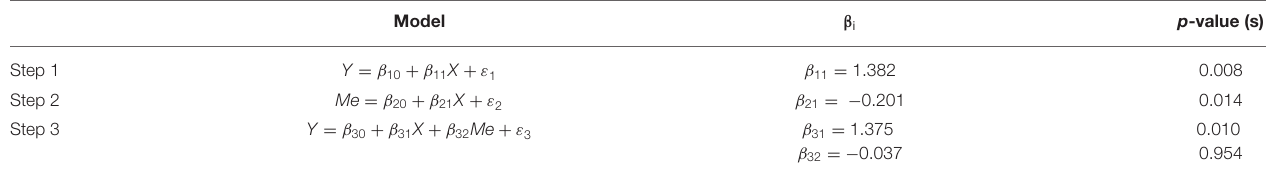
TABLE 5 | Mediation analysis to determine the causal mediated effect of placental relative mtDNAcn on the association between prenatal NO x exposure and